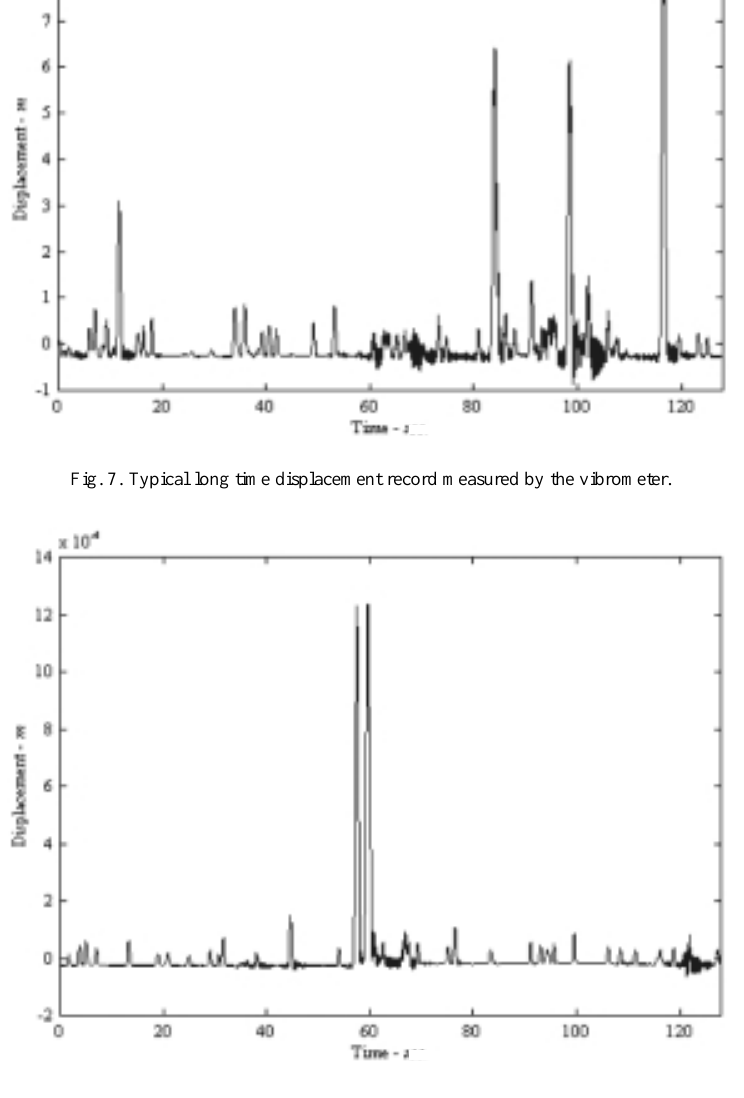
Fig. 8. Typical long time displacement record measured by the